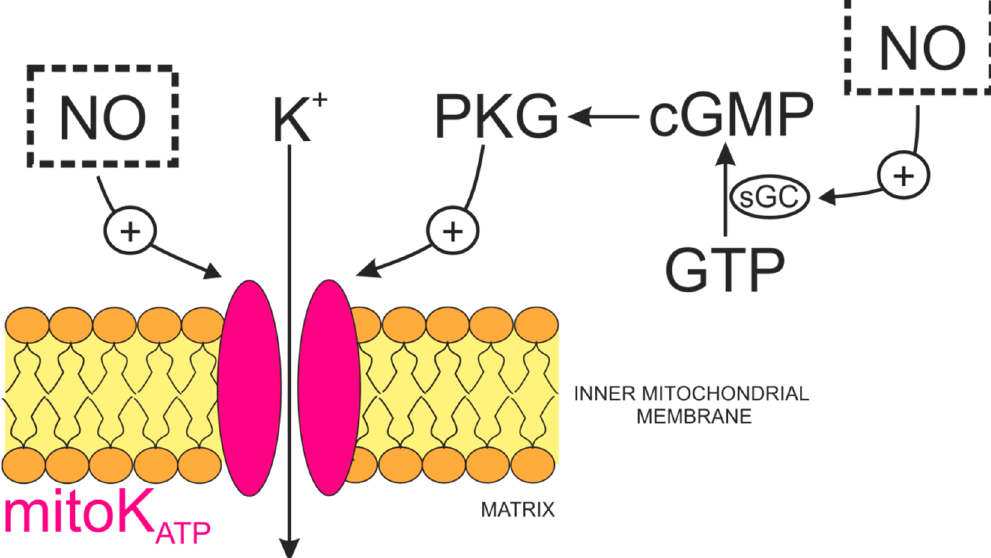
Figure 3. Regulation of the ATP-sensitive potassium channel (mitoK ATP ) activity by NO. The activity of the channel is stimulated (+) directly by NO (gasotransmitter shown in the dotted box). Independently, NO could stimulate sGC/cGMP/PKG pathway leading to channel phosphorylation and activation. Abbreviations: PKG, cGMP-dependent protein kinase; sGC, soluble guanylate cyclase.